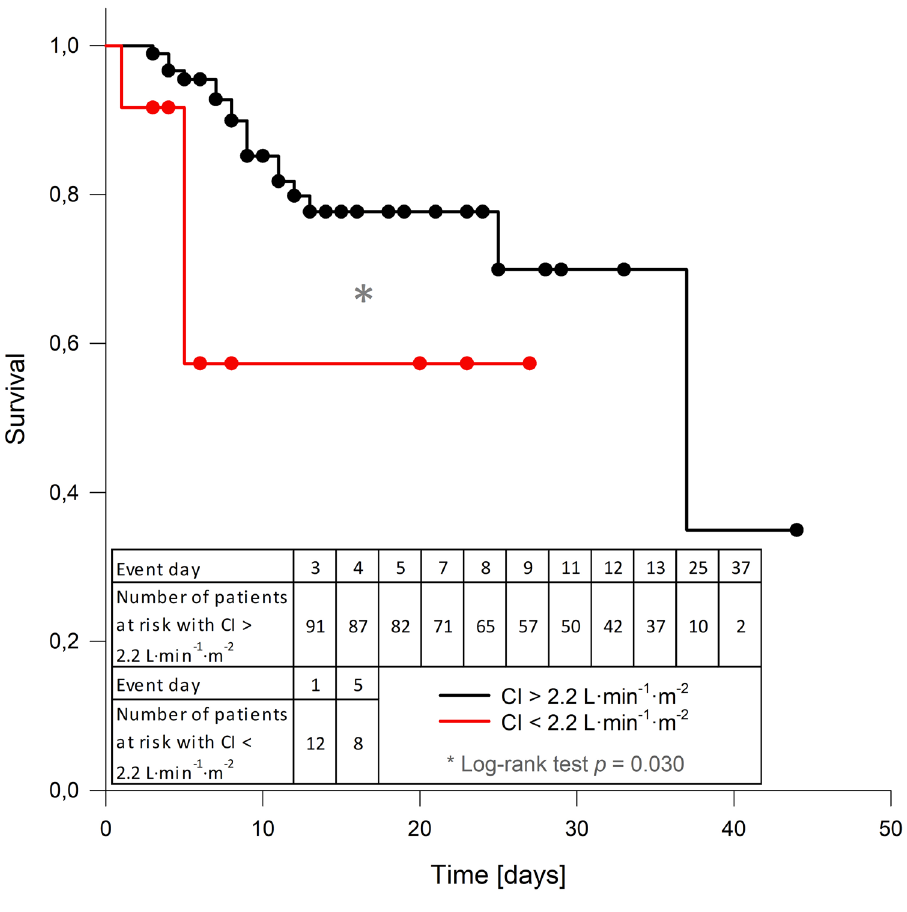
Figure 4. Kaplan–Meier survival